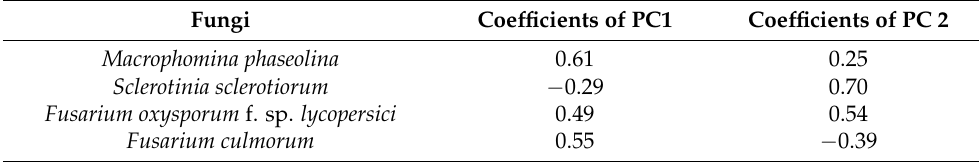
Table 4. Extracted eigenvectors of first two principal